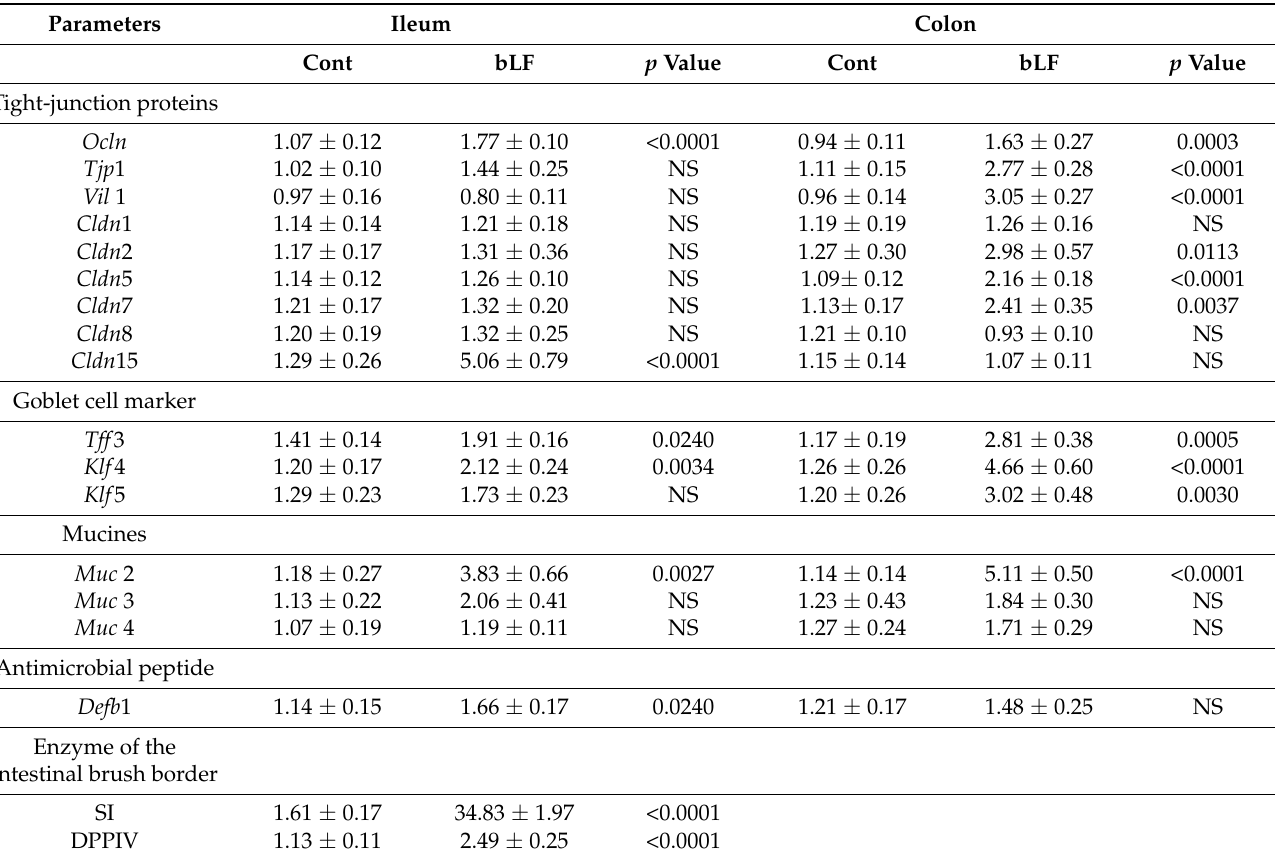
Table 5. Gene expression of the intestinal barrier function in ileum and colon of pups recovered from mothers receiving the control diet or the bLF-supplemented diet. The parameters were determined at postnatal day